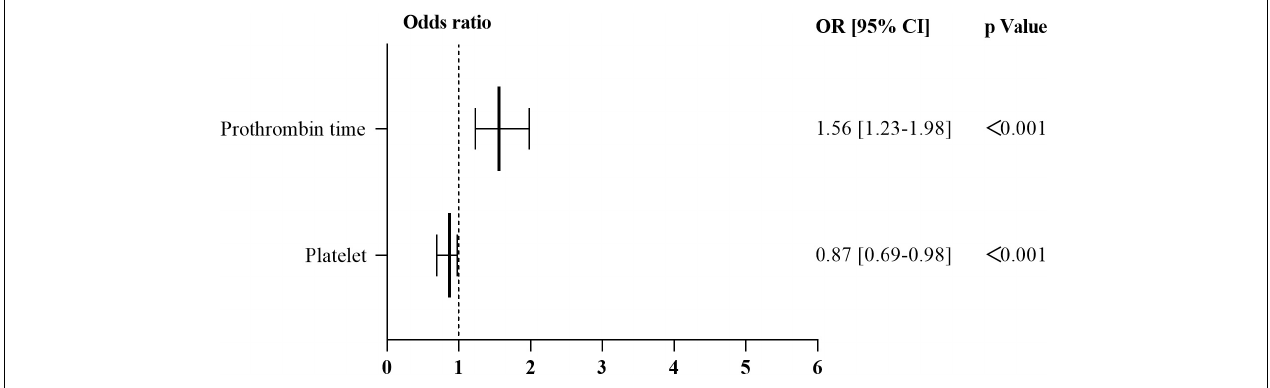
FIGURE 7 | Results of multivariate logistic regression analysis relating to the onset of SAH in the propensity score–matched group. OR > 1 independent risk factor for the onset of SAH. OR of 1 corresponds to no effect. OR, odds ratio; 95% CI, 95% confidence interval; SAH, subarachnoid hemorrhage.